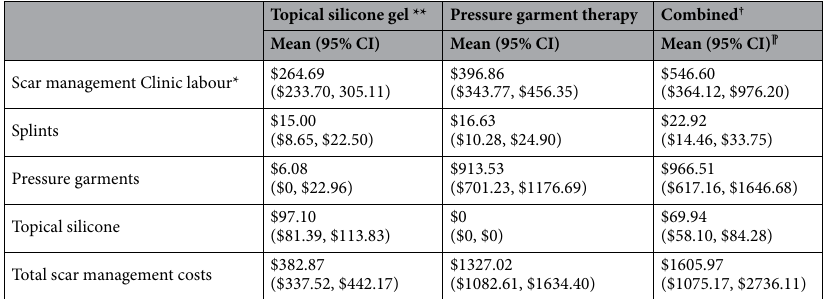
Table 2. Clinical costs (health service perspective) for each treatment group. *Includes occupational therapist labour and allied health assistants; ** Intention to treat analysis: 2 participants deviated from the topical silicone gel only (n = 1) or pressure garment only (n = 1) groups to receive combined topical silicone gel + pressure garment therapy. † Combined = pressure garment therapy + topical silicone gel ⁋ 95% confidence intervals (CIs; bias corrected) derived from bootstrap resampling (2000